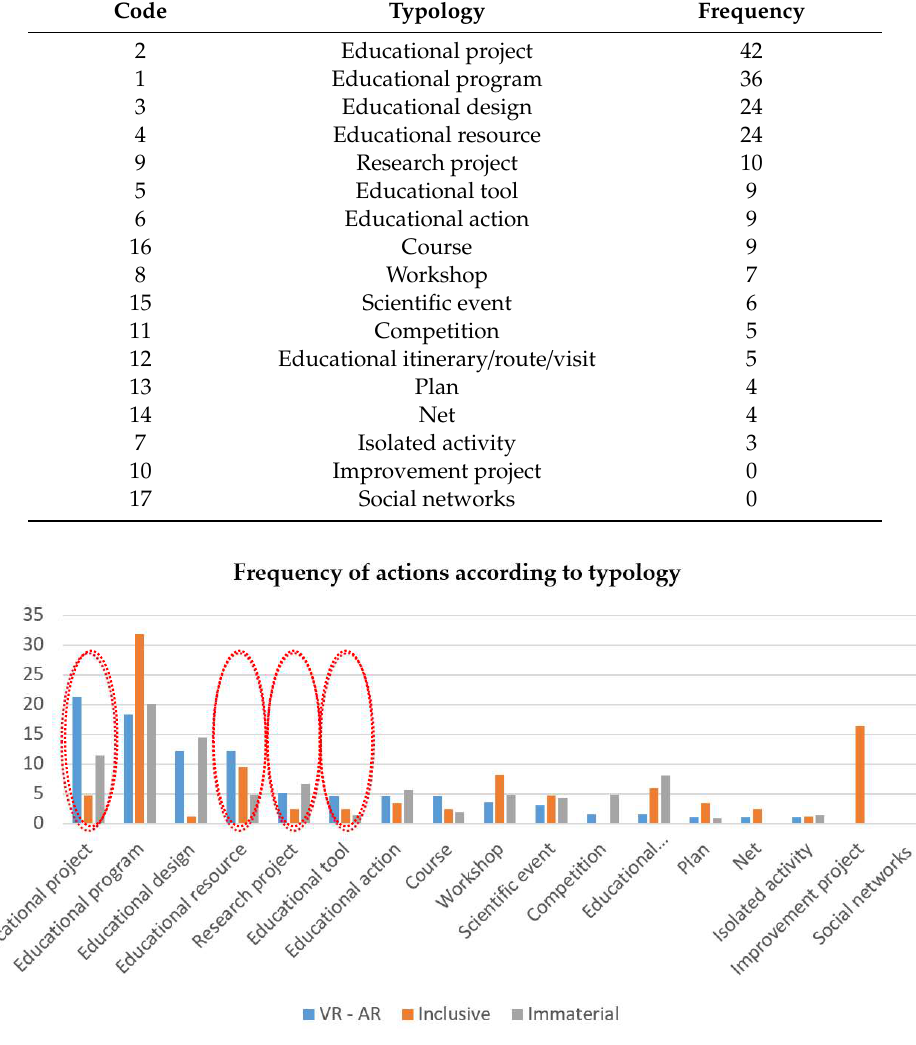
Figure 1. Frequency of actions according to typology .